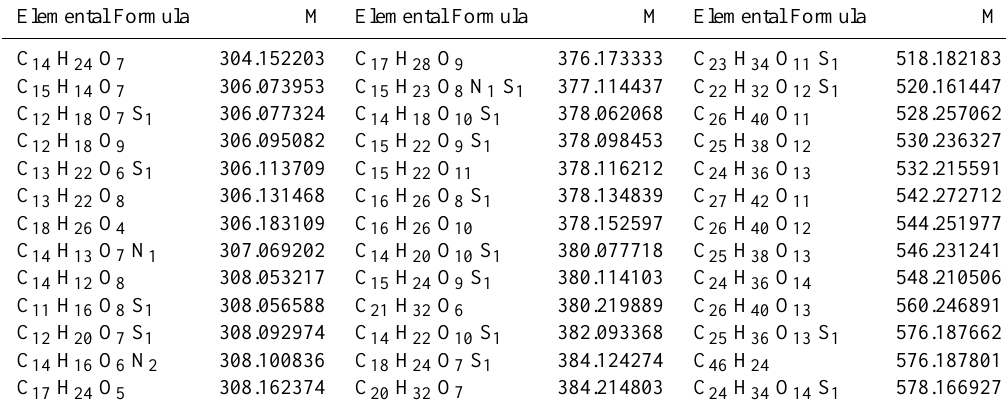
Table A1. Continued.